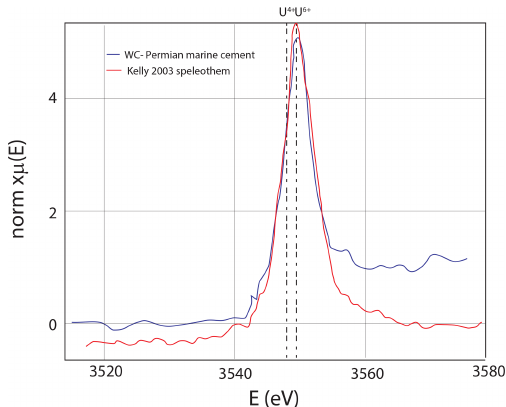
Figure 8. U M 5 edge X-ray absorption spectroscopy, with 20 scans (15s each) showing that uranium is in the oxidized state. The TES beamline has a monochrometer that is very stable, allowing for hours worth of scanning without drift. Speleothem from a cave in Austria (Kelly et al., 2003) that has U 6 + for reference.